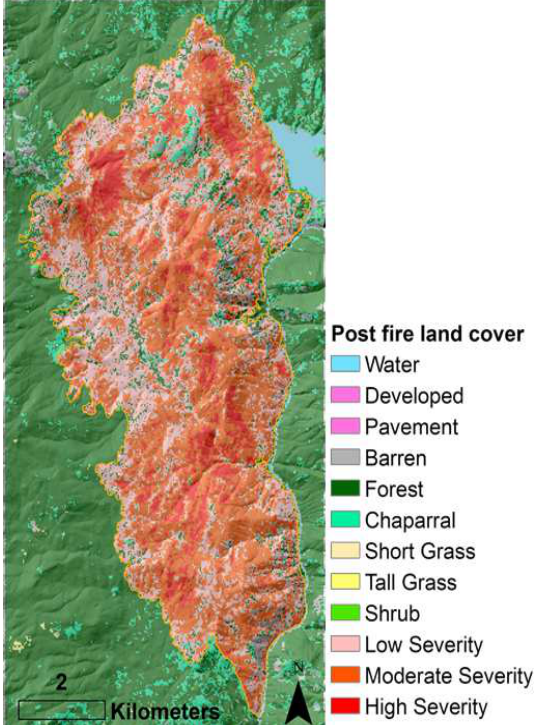
Figure 3. Example post-fire land cover map generated by the database for the French Fire.